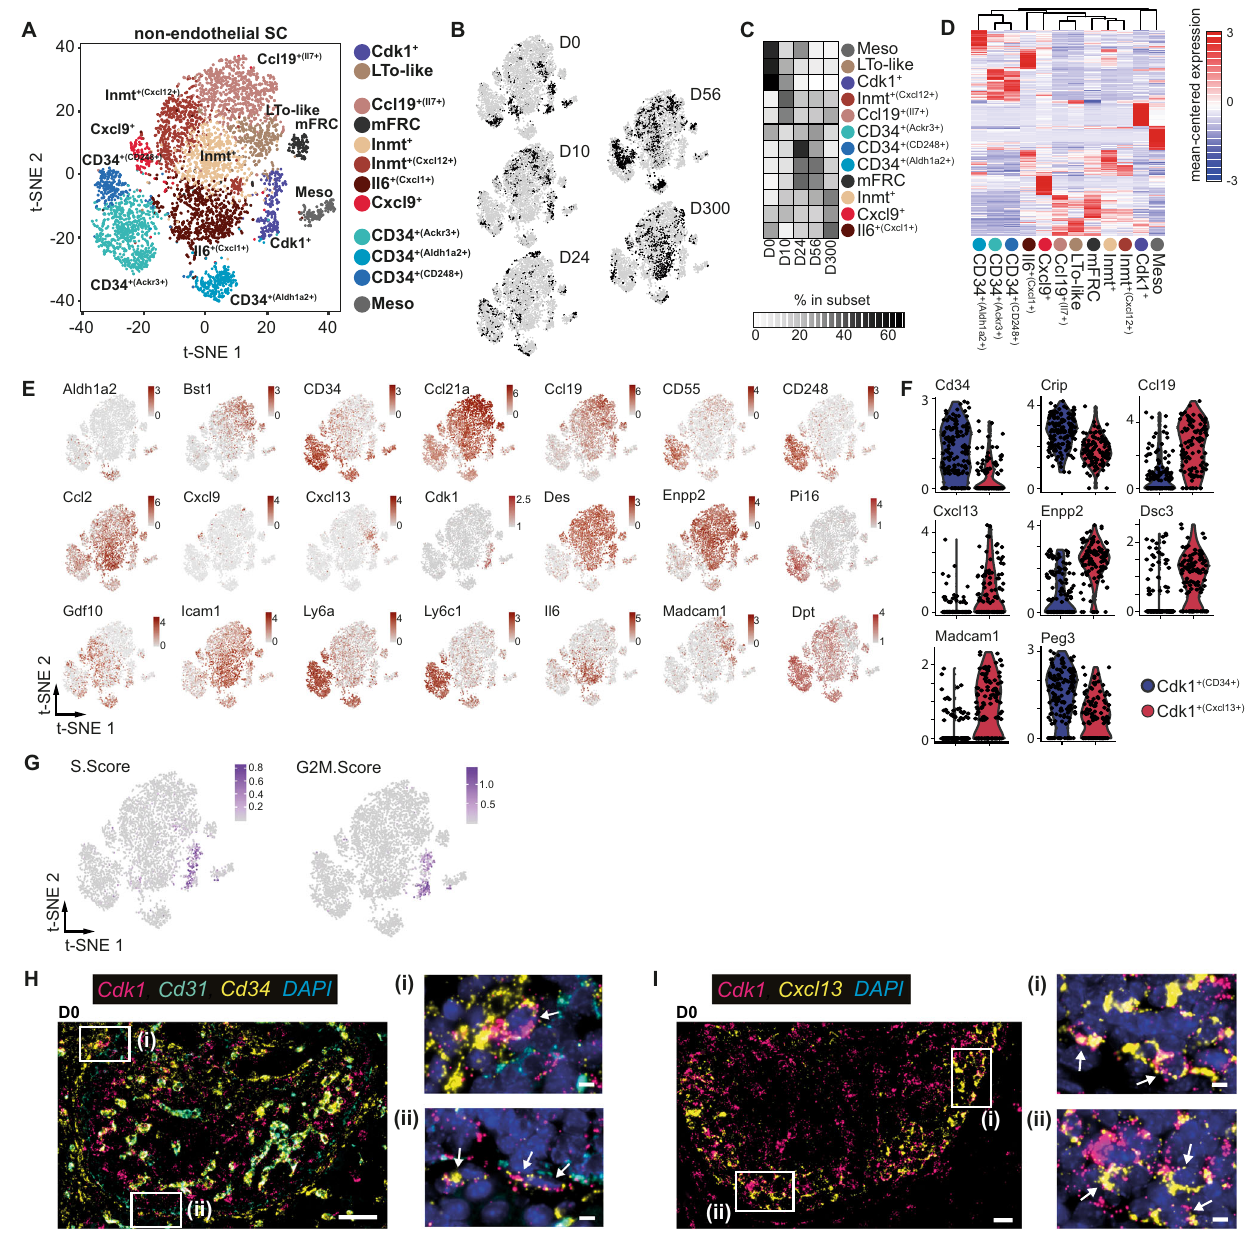
Fig. 1 | Postnatal ontogeny of non-endothelial SCs within mLNs. CD45 - CD24 - cells were isolated from mLNs of day 0, 10, 24, 56, and 300 old SPF-housed mice and subjected to scRNA-seq. One replicate was performed for day 0, 10, 24, and 300 time points, and two replicates were generated for day 56 time point. Non- endothelial SCs wereidenti fi ed asnon-LECs, non-BECs, and non-PvCs. A t-SNE plot of merged SCs across ages showing cluster segregation. B t-SNE plot of SCs from each age. C The heatmap represents the percentage of cells in each subset across time points normalized to cell number. D Hierarchical clustering of subsets based on the mean expression of the Top 40 DEGs per subset. E t-SNE plot colored for expressionofsegregatinggenes. F ViolinplotofDEGsforsubsetsidenti fi edamong putative postnatal progenitors. G t-SNE summarizing the expression of S-phase (left) and G2M-phase (right) associated genes as the cumulative Z-score. H , I Sections(3 µ m)ofD0neonatalmLNwerestainedwiththeindicatedRNAscope